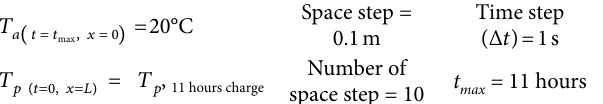
Figure 15: Temperature of storage versus temperature of water during boiling of 5 liters of water by natural convection and conduction where the pot is put on the storage after charging a thermocline for 11 h for higher DNI.